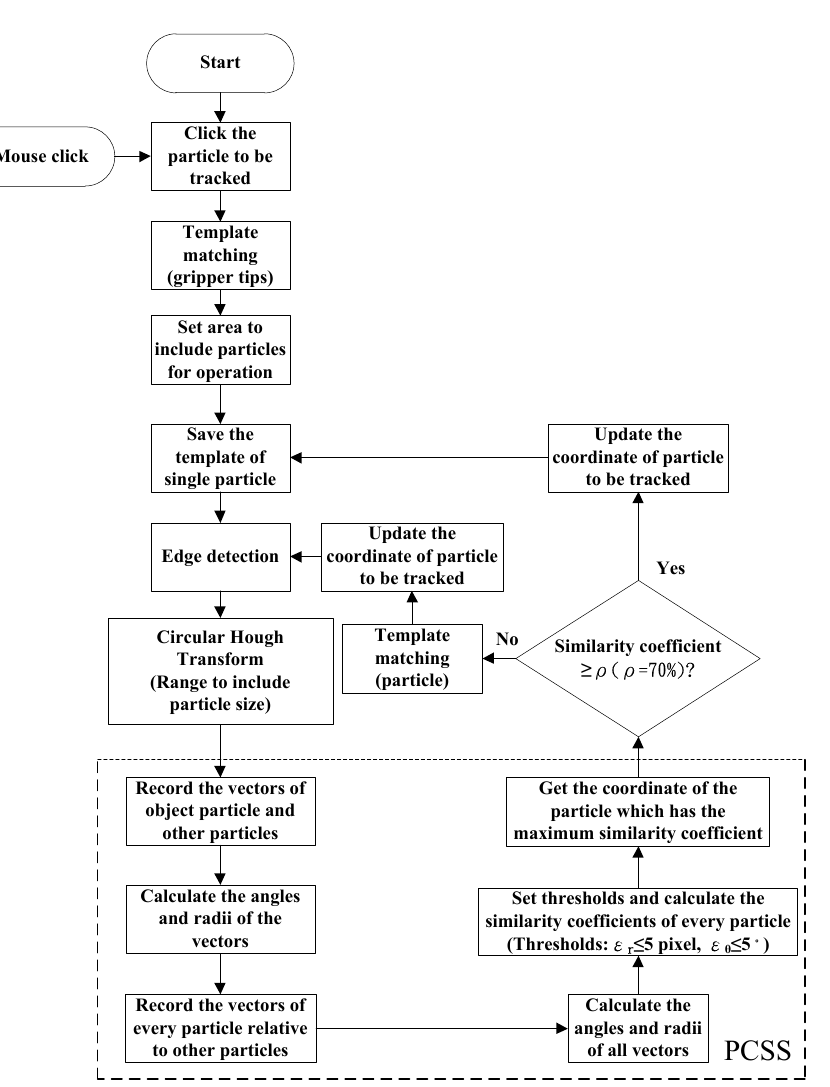
Figure 10. Enhanced PCSS for tracking micro particle on X - Y plane.